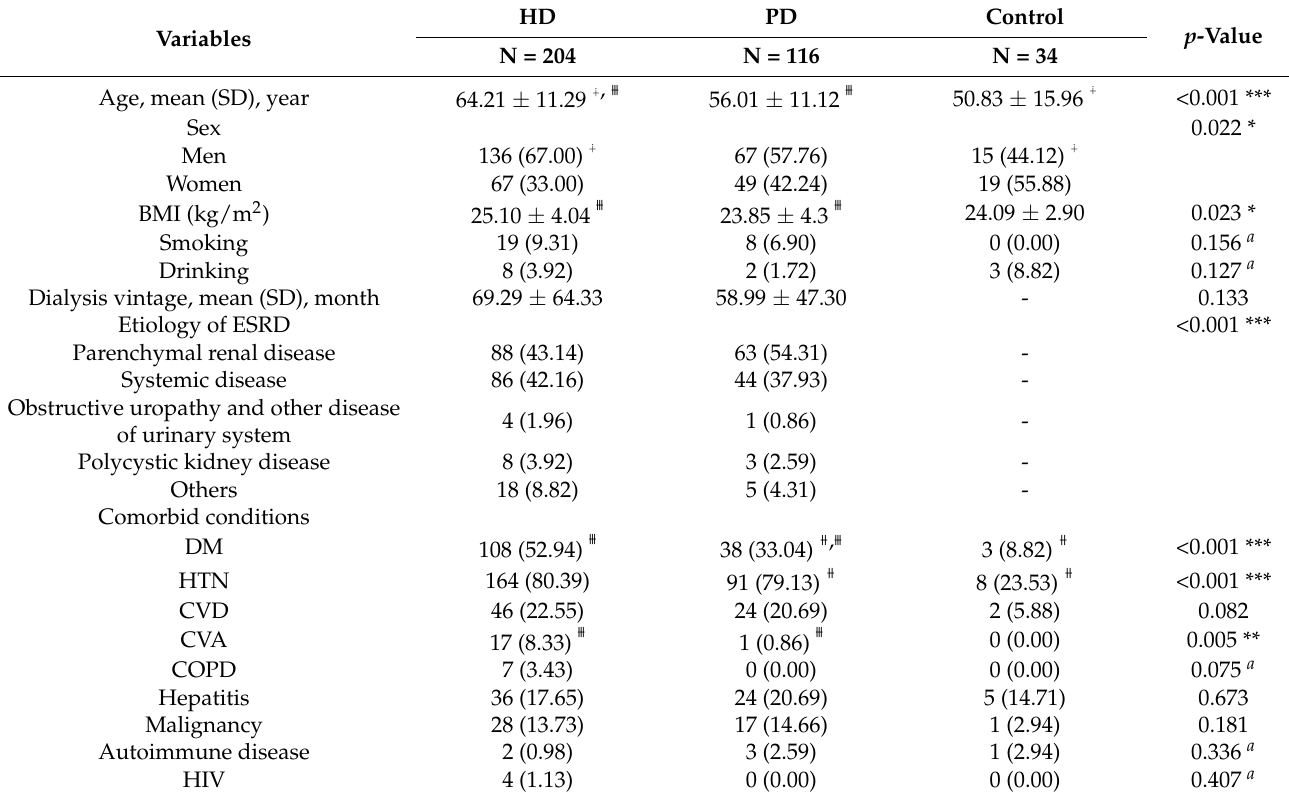
Table 1. Baseline demographic data and characteristics of the subjects in the study.